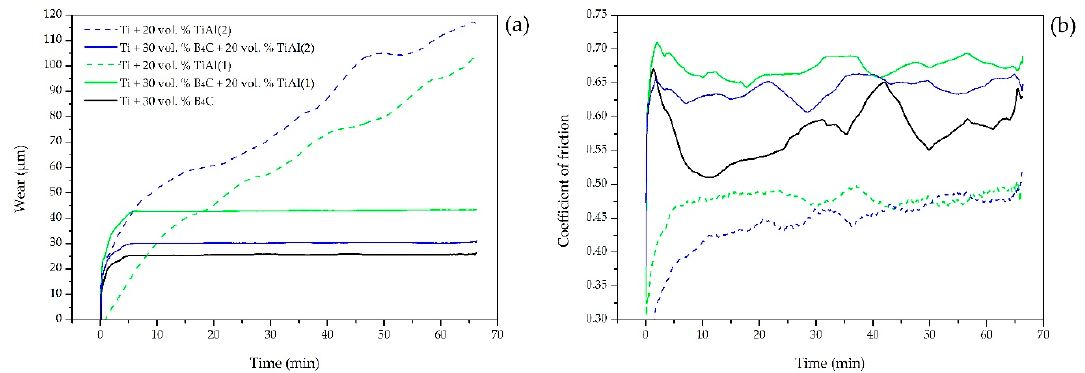
Figure 10. Tribology results: ( a ) wear vs. time and ( b ) coefficient of friction vs. time.